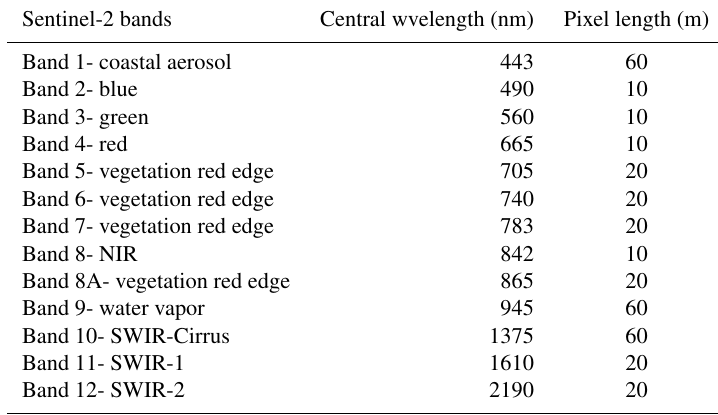
Table A3. Overview of Sentinel-2 spectral bands, spatial resolution, and the central wavelength.